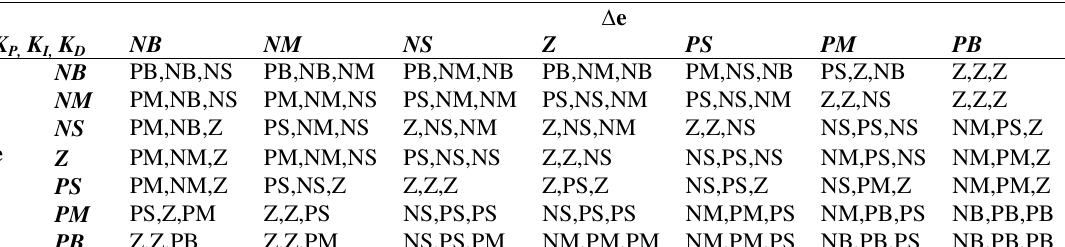
Fig . 3. The blocks diagram of the fuzzy-PID controller. Table 3, , K , and K Rule of K P I D